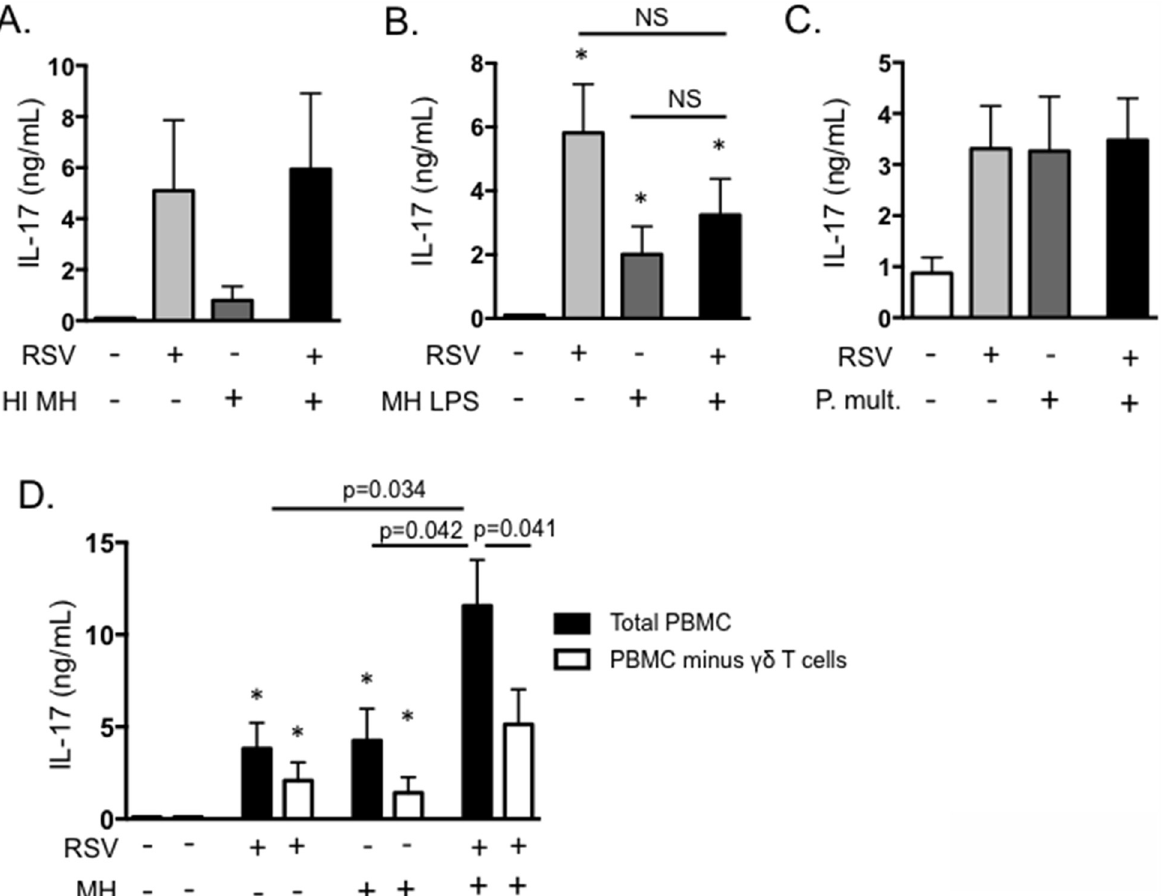
Fig 8. γδ T cells are the primary source of exacerbated IL-17 production in an in vitro model of BRDC. (A and B) PBMC from BRSV vaccinated cows were stimulated with BRSV for 6 hours, then with 0.1 MOI of heat-inactivated M . haemolytica (A) or 1 μ g/mL purified LPS from M . haemolytica (B). Control cells remained unstimulated, were stimulated with only BRSV or were stimulated with only heat-inactivated M . haemolytica LPS. After six days, cell culture supernatants were analyzed by ELISA for IL-17. (C) PBMC from BRSV vaccinated cows were stimulated with BRSV for 6 hours, then cultured with 0.1 MOI P . multocida in antibiotic free media for 4 hours. After four hours, antibiotics were added, and then incubations were continued for 6 days. Control cultures were included that received neither pathogen, BRSV alone or P . multocida alone. Cell culture supernatants were analyzed by ELISA for IL-17. (D) PBMC were depleted of γδ T cells using MACS. Total PBMC and γδ T cell-depleted PBMC were then cultured in the presence of BRSV and M . haemolytica as above. After 6 days, cell culture supernatants were analyzed by ELISA. Results in A-C are from one experiment with n = 4. Results in D are pooled from 2 independent experiments with n = 8. Data represent means ±